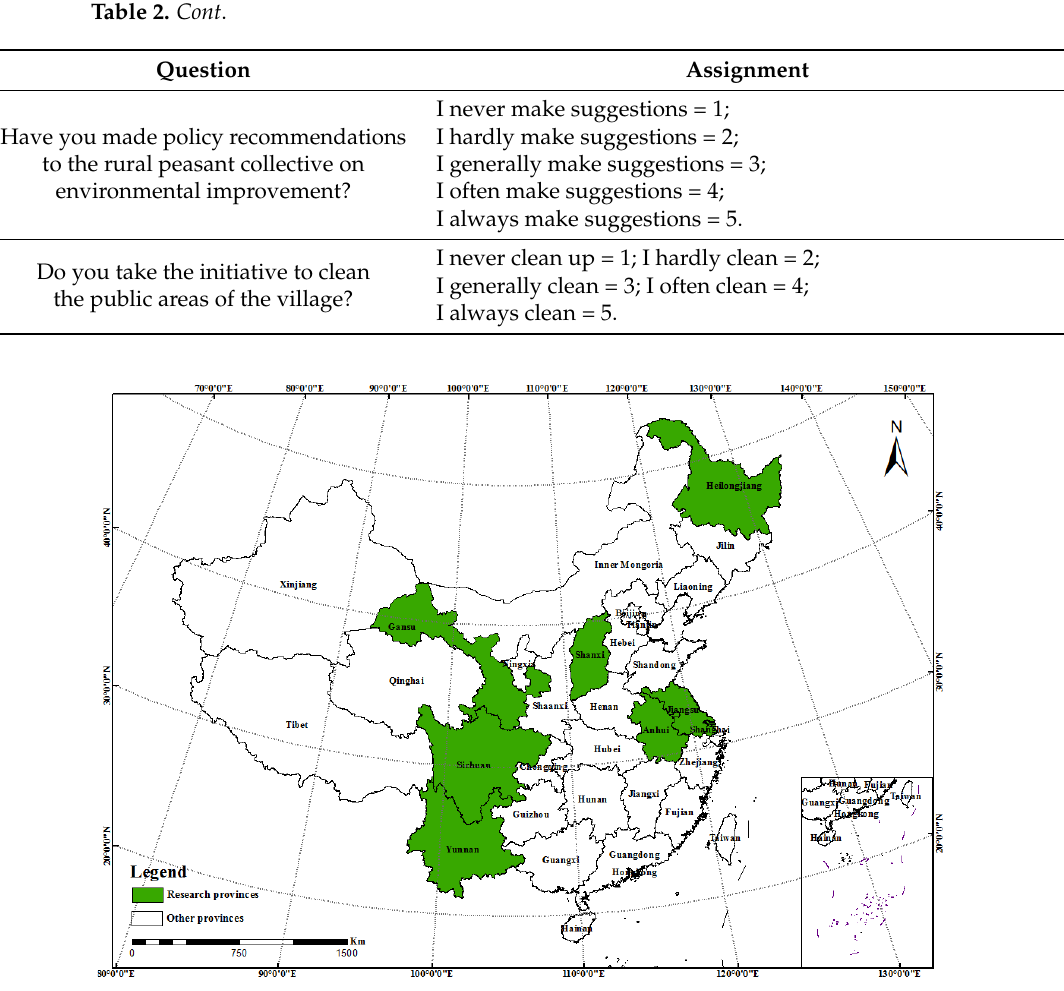
Figure 1. Distribution of research provinces. Table 3. Research area and distribution of sample farmers .